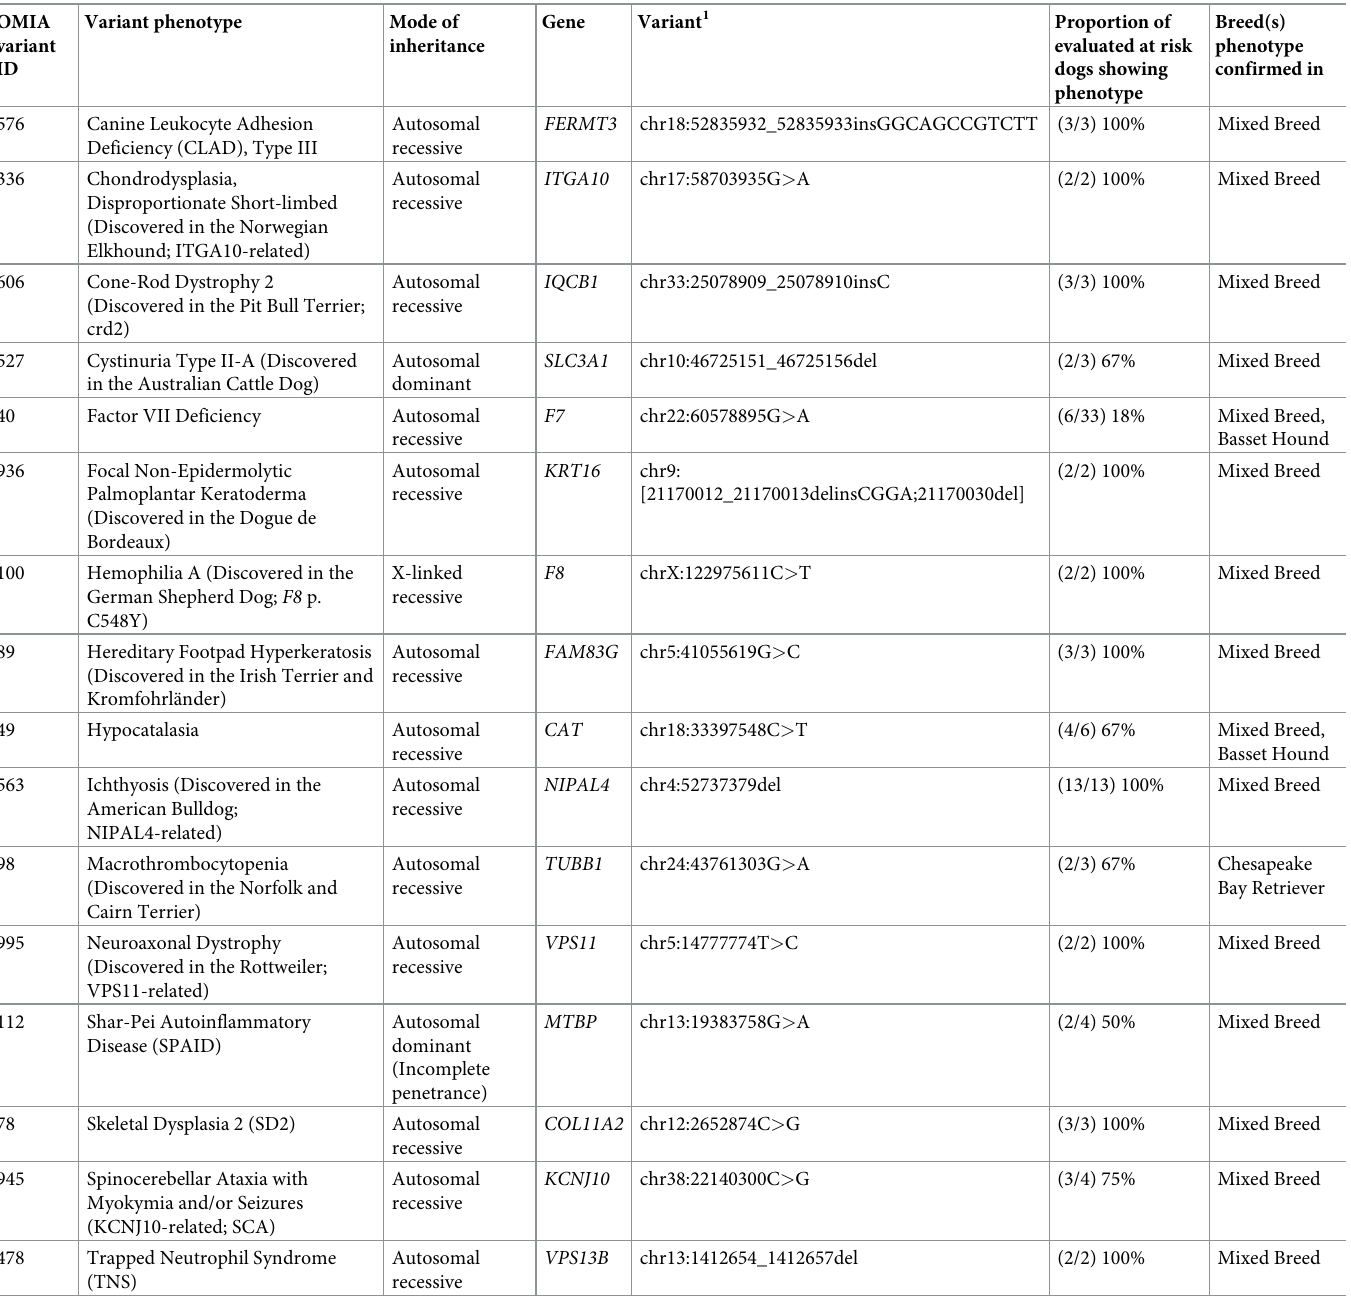
Table 3. Key EMR (electronic medical record)-based clinical validation